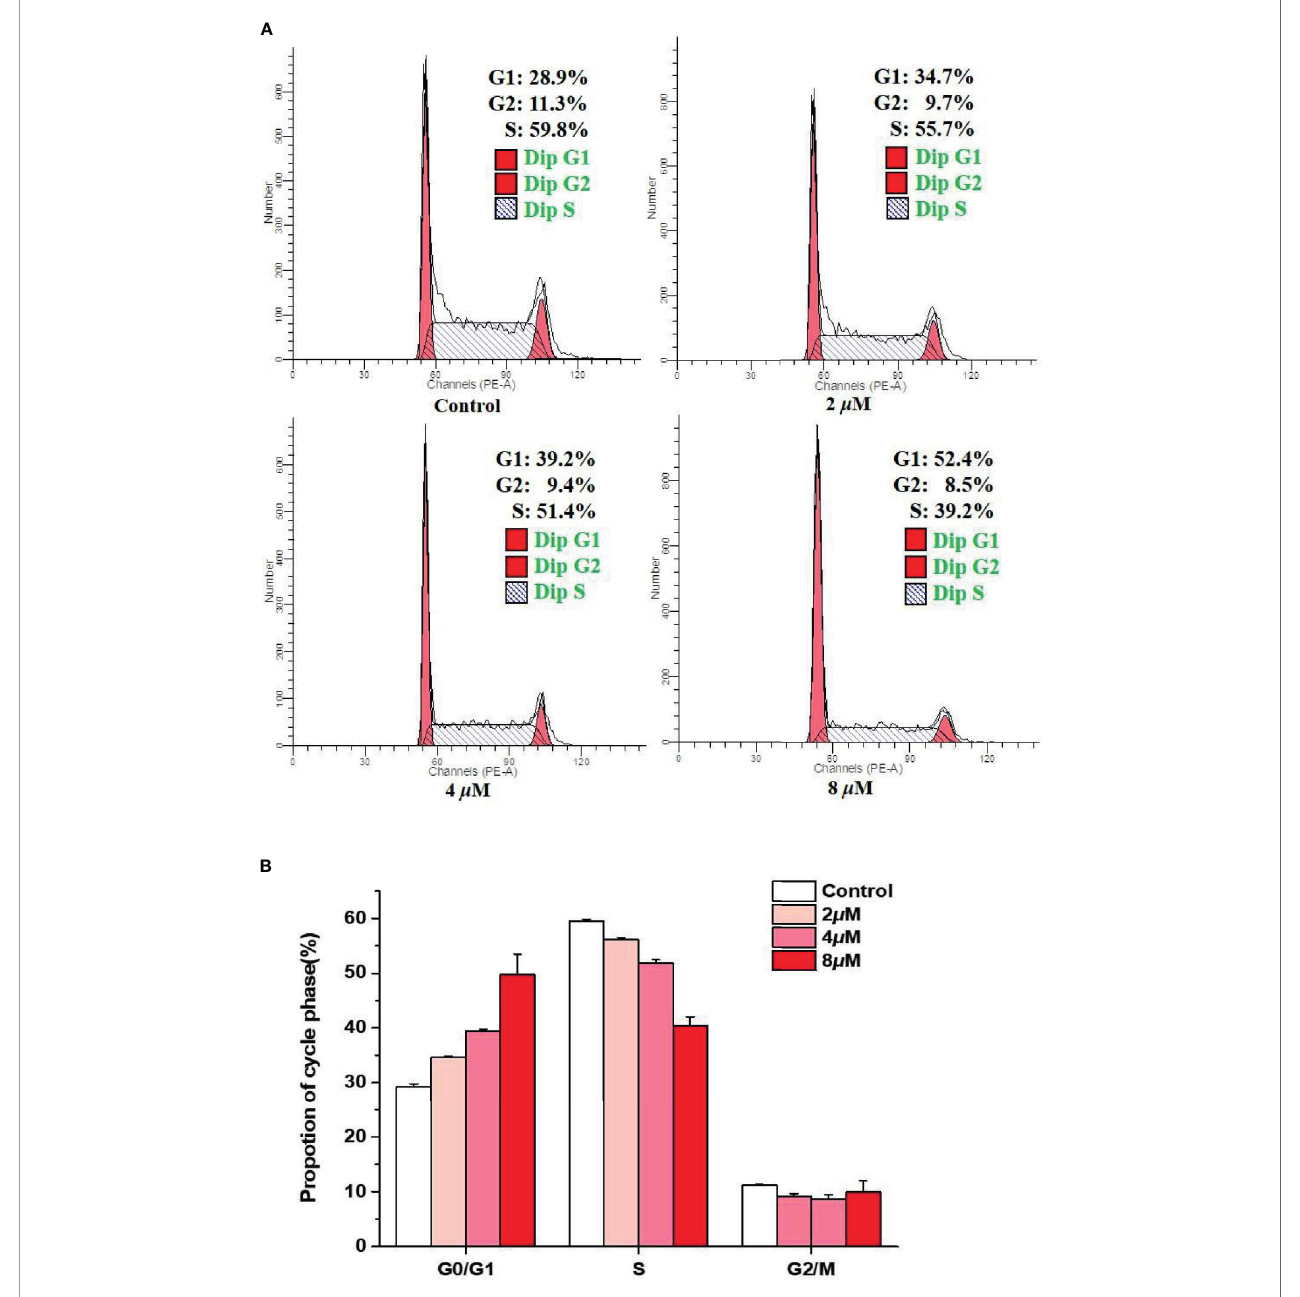
FIGURE 3 | Arrest effects of casearlucin A on HepG2 cell cycle. HepG2 cells were treated with different concentrations (2, 4, and 8 m M) of casearlucin A for 48 h. DMSO was used as a negative control. (A) The cells were harvested and stained with propidium iodide (PI), and the cell cycle distribution was analyzed using fl ow cytometry. (B) Data processing of cell cycle distribution. Data from three separate experiments are expressed as means ±